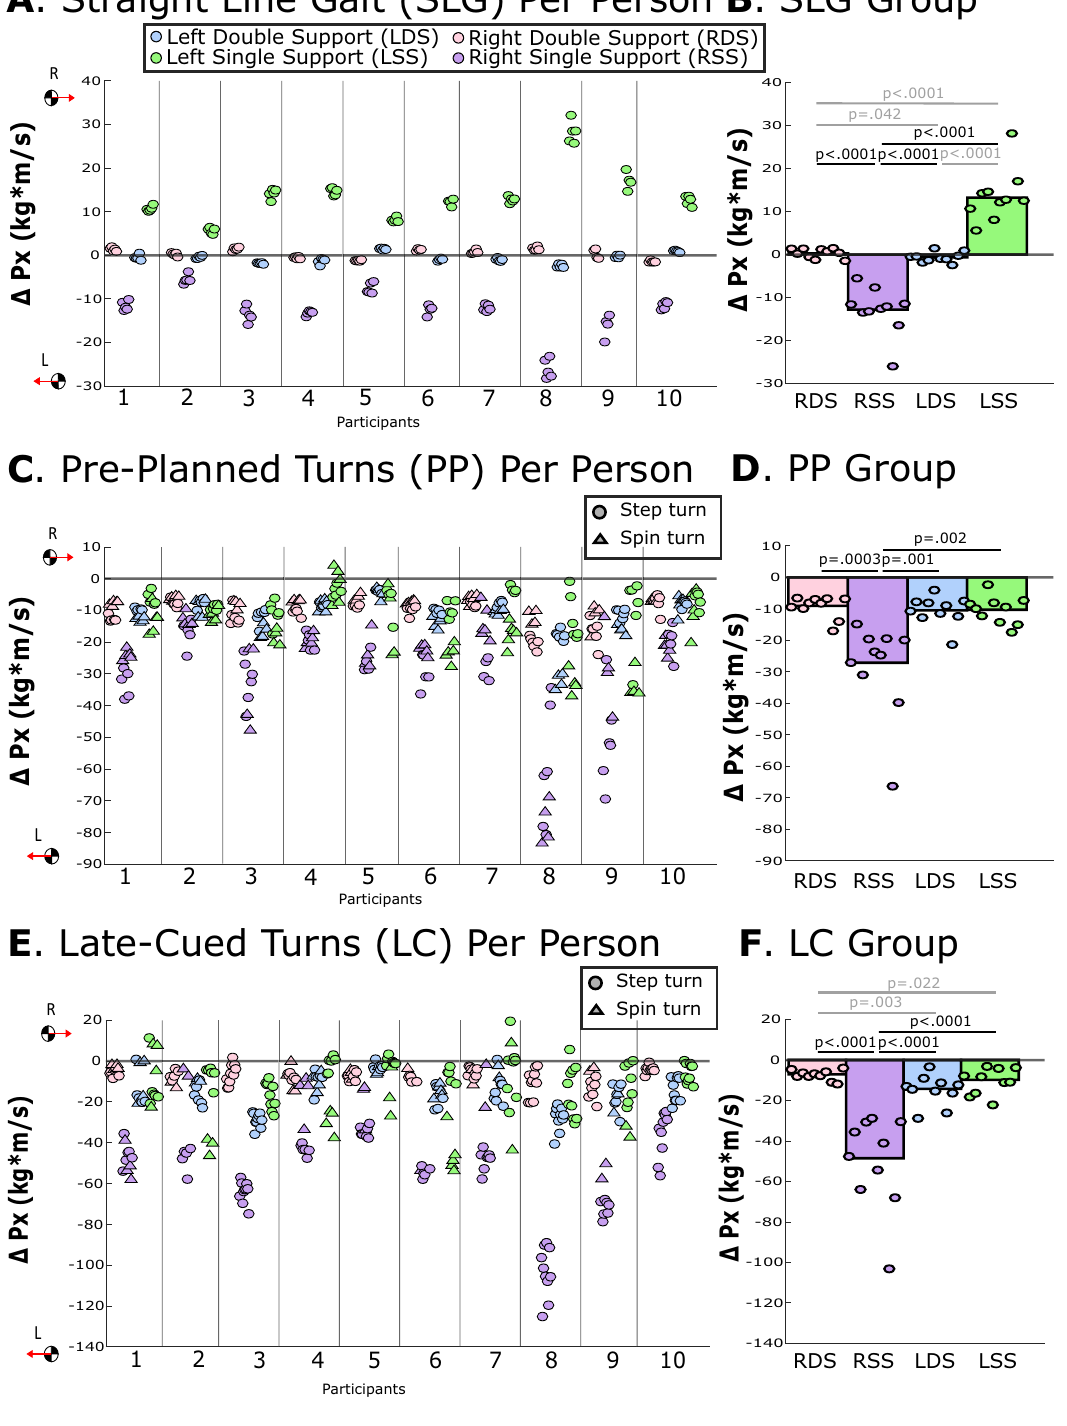
Figure 3. The change in global X-axis linear momentum (∆p x ) for each gait phase during ( A , B ) straight-line gait, ( C , D ) pre-planned turns, and ( E , F ) late-cued turns. Negative p x is leftward in the direction of the turn. The left panel ( A , C , E ) provides average ∆p x for each gait phase, each trial, and each participant, with step turns indicated with circles and spin turns indicated with triangles. In the right panel ( B , D , F ), each circle indicates the average value for each participant across multiple trials and the bar represents the across-participant (group) averages. Horizontal lines with p-values indicate statistically significant differences between gait phases at the group level, those in gray are significant differences that were not related to the